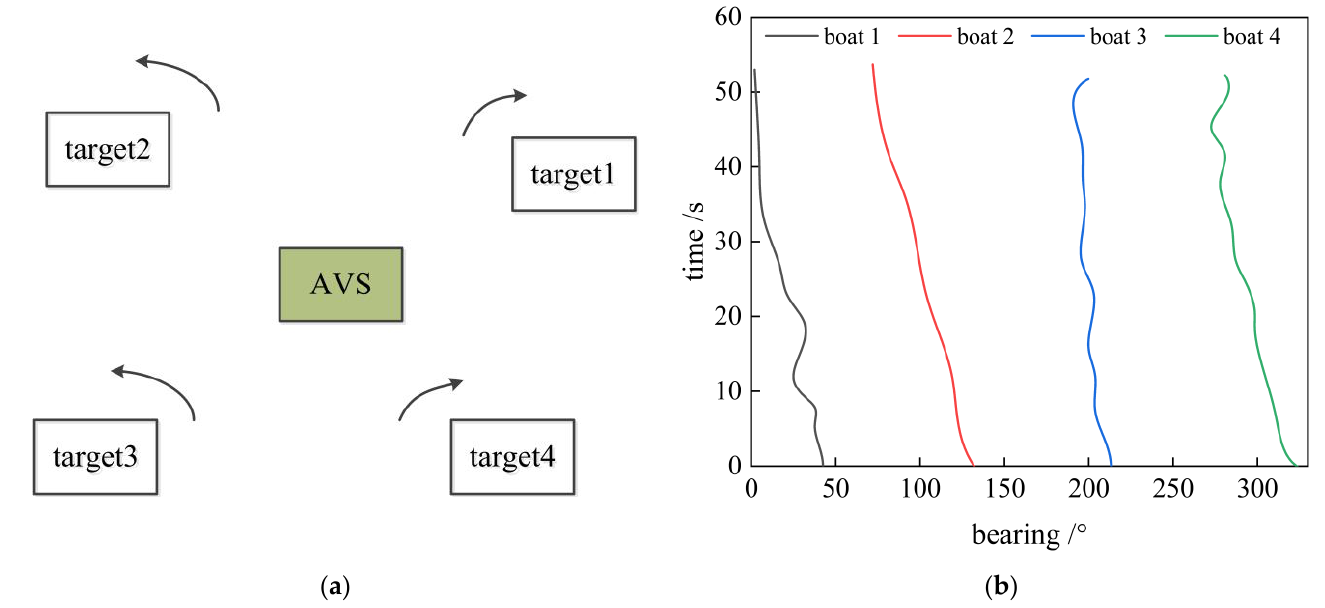
Figure 3. Experimental setup and traces of four boats: ( a ) experimental setup; ( b ) experiment azimuth waterfall sketch map.